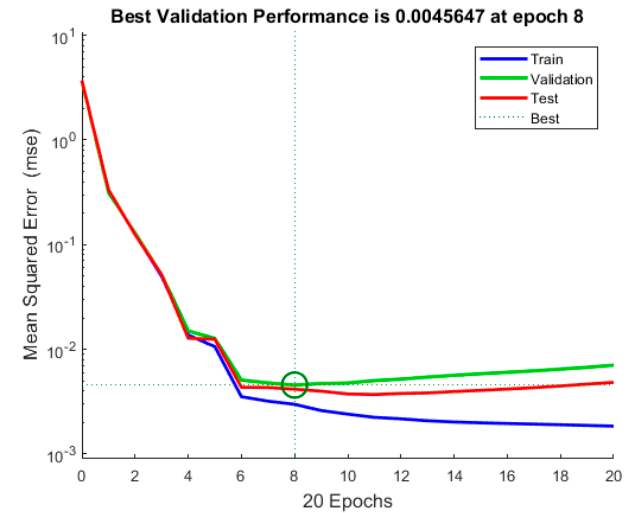
Figure 9. Performance function values obtained during the learning process for the best analyzed neural network.